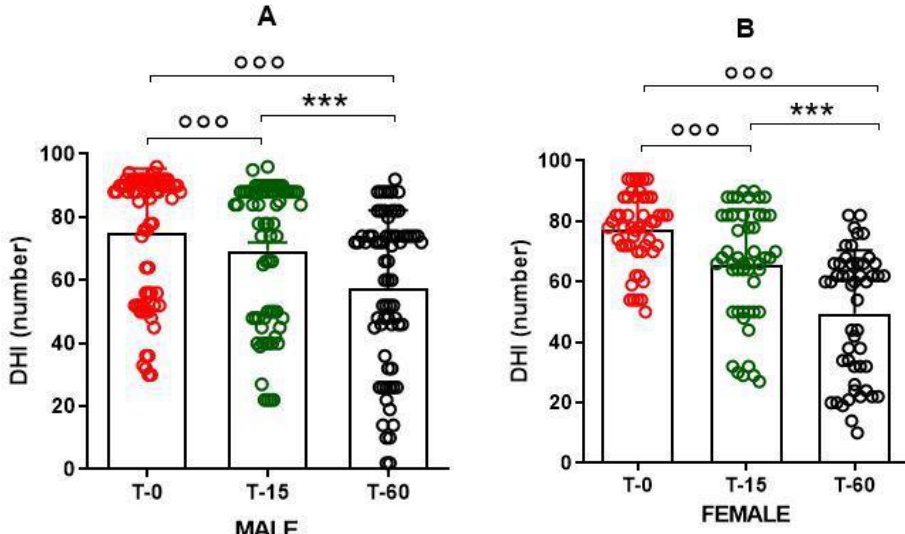
Figure 3. Reduction of dizziness symptoms, evaluated using the Dizziness Handicap Inventory (DHI), assessed at different times after pharmacological treatment with a fixed-combination preparation of cinnarizine (20 mg) plus dimenhydrinate (40 mg). Data refer to ( A ) n = 70 male, and ( B ) n = 50 female patients, and are represented as the mean ± SD of DHI symptoms. *** p < 0.001 vs. T15; ◦◦◦ p < 0.001 vs. T0. T0: baseline; T15: evaluation after 15 days from the start of therapy; T60: evaluation at the end of